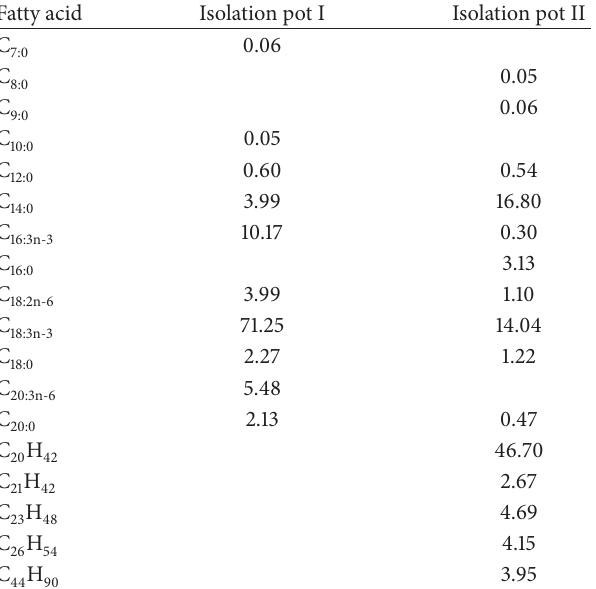
Table 1: Fatty acid composition in pollen’s extraction of cole pollen [%]. Fatty